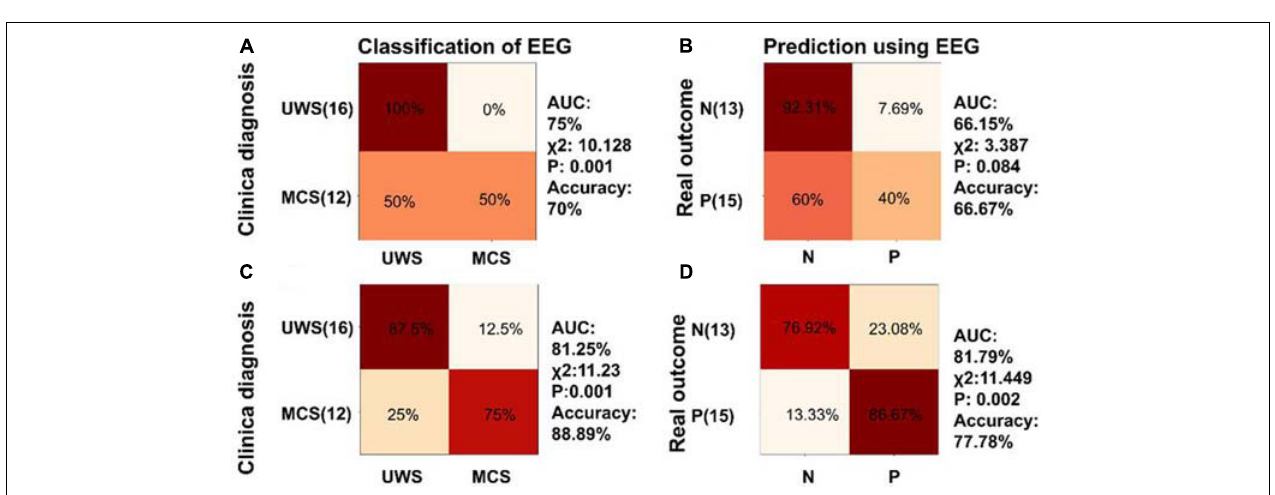
FIGURE 8 | Classification and diagnosis prediction using speech tracking response and combination of low frequency aSSR and speech tracking responses. (A,B) Confusion matrix generated by the SVM classifier trained by the phase coherence to the natural speech in delta and theta bands for classification and prognosis prediction of DOC. (C,D) Confusion matrix generated by the SVM classifier trained by the combination of the phase coherence to modulated tones at 2, 4 Hz, and the phase coherence to natural speech in delta, theta bands for classification and prognosis prediction of DOC. The SVM classifiers showed better performance in classification and prognosis prediction of DOC compared with SVM classifiers separately trained with phase coherence at 2 and 4 Hz or the phase coherence to natural speech in delta and theta